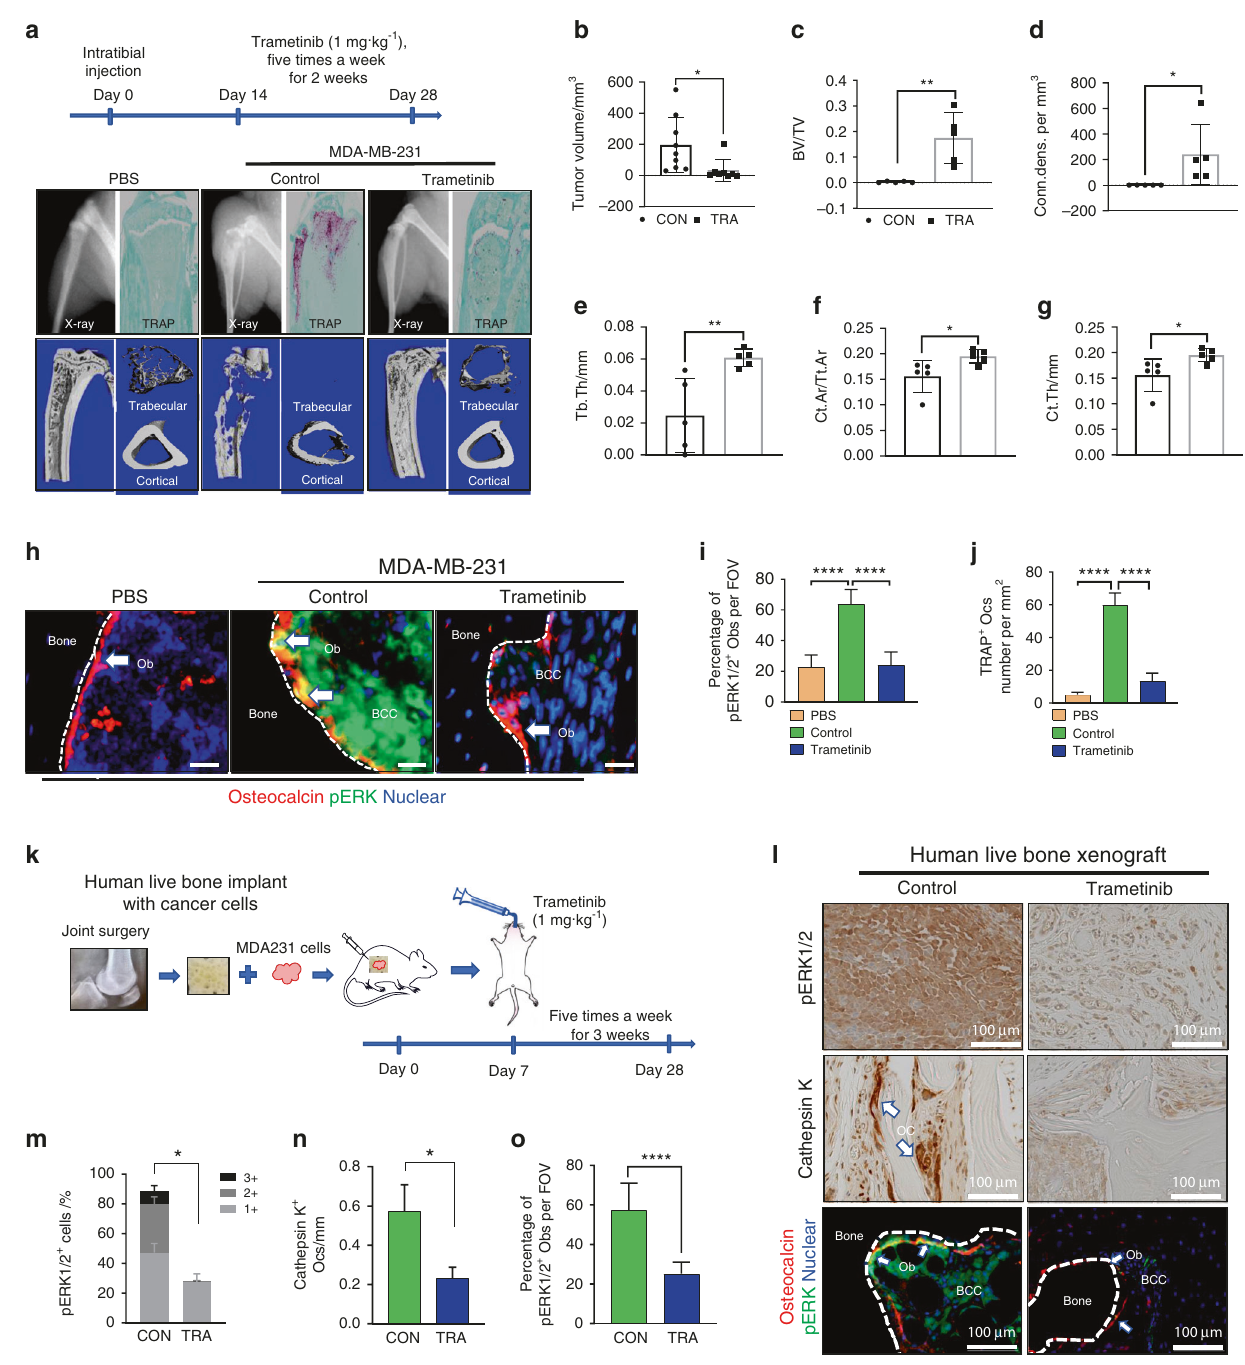
Fig. 6 Pharmacologic targeting of the MEK1/2-pERK1/2 axis decreases cancer-induced bone destruction. a MDA-MB-231 cells were injected in the tibiae of Balb/c nude mice. Treatments began on day 14 after injection. Trametinib (1 mg/kg oral fi ve times weekly) was administered by oral gavage (o.g.) for 2 weeks. Representative micro-CT images of tibiae collected from nontumor-bearing and tumor-bearing mice after trametinib treatment. b Comparison of tumor volumes (in mm 3 ) in murine tibiae (control: n = 9; trametinib: n = 8). P values were calculated using a two-tailed Student ’ s t test. Bone volume fraction ( c ), connectivity density ( d ), trabecular thickness ( e ), cortical area fraction ( f ), and cortical thickness ( g ) determined using a Scanco μ CT 35 system. n = 5 mice per group. P values were calculated using the two-tailed t -test. h Representative images of pERK1/2 + Obs found in the trametinib-treated and untreated murine tibiae. i Quanti fi cation of pERK1/2 + osteoblasts in murine tibiae with breast cancer cells. pERK1/2 + Obs number calculated from images from the experiment in ( h ). One-way ANOVA was performed with Dunnett ’ s multiple comparisons. j Quanti fi cation of TRAP + osteoclast number under different experimental conditions. TRAP + osteoclast number calculated from images from the experiment in ( a ). One-way ANOVA was performed with Dunnett ’ s multiple comparisons. k Schematic representation of the trametinib experimental design using live human bone samples. l A representative image showing ERK1/2 activation in the bone microenvironment, which includes osteoblasts highly expressing pERK1/2 and Cathepsin K + osteoclasts surrounding MDA231 cells. Scale bar: 100 μ m. Quanti fi cation of pERK1/2 + cells ( m ), Cathepsin K + osteoclasts ( n ), and pERK1/2 + Obs ( o ) in ( i ) (control: n = 6; trametinib: n = 9). Two-tailed Student ’ s t tests were